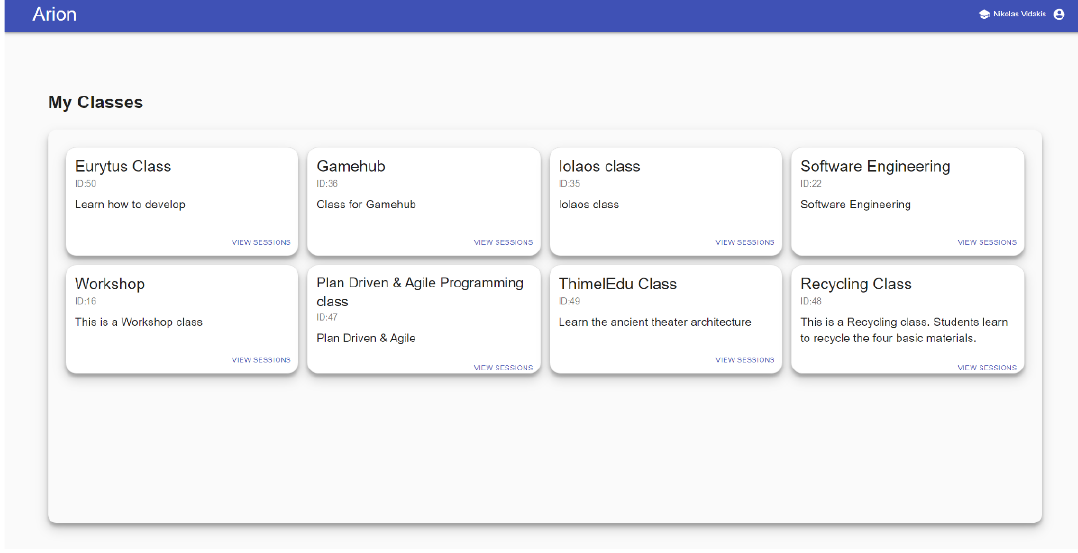
Figure 4. Available Classes View.